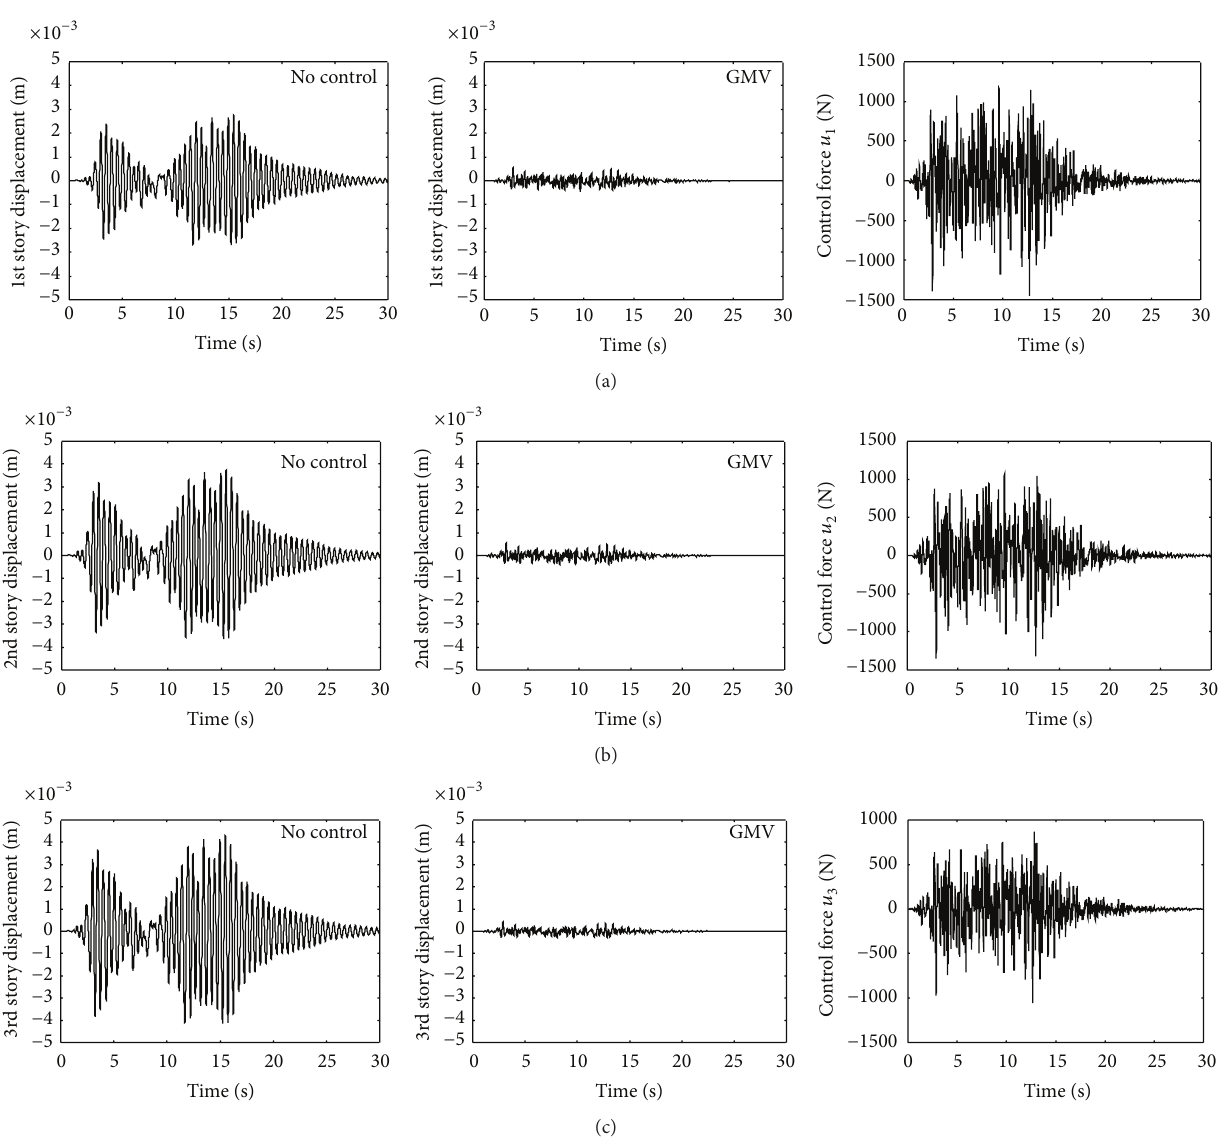
Figure 3: Structural response to Kanai-Tajimi ground acceleration. (a) 1st story, (b) 2nd story, and (c) 3rd story.